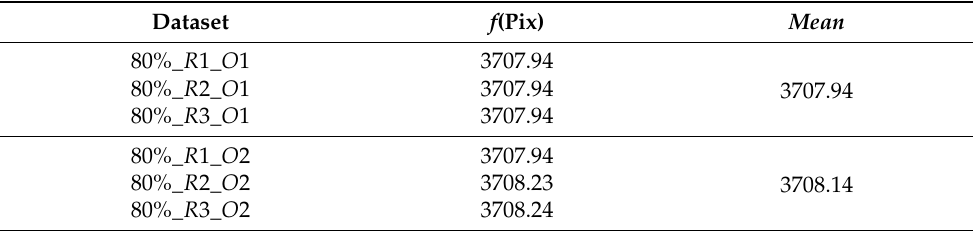
Table 9. The results of focal length estimates for different